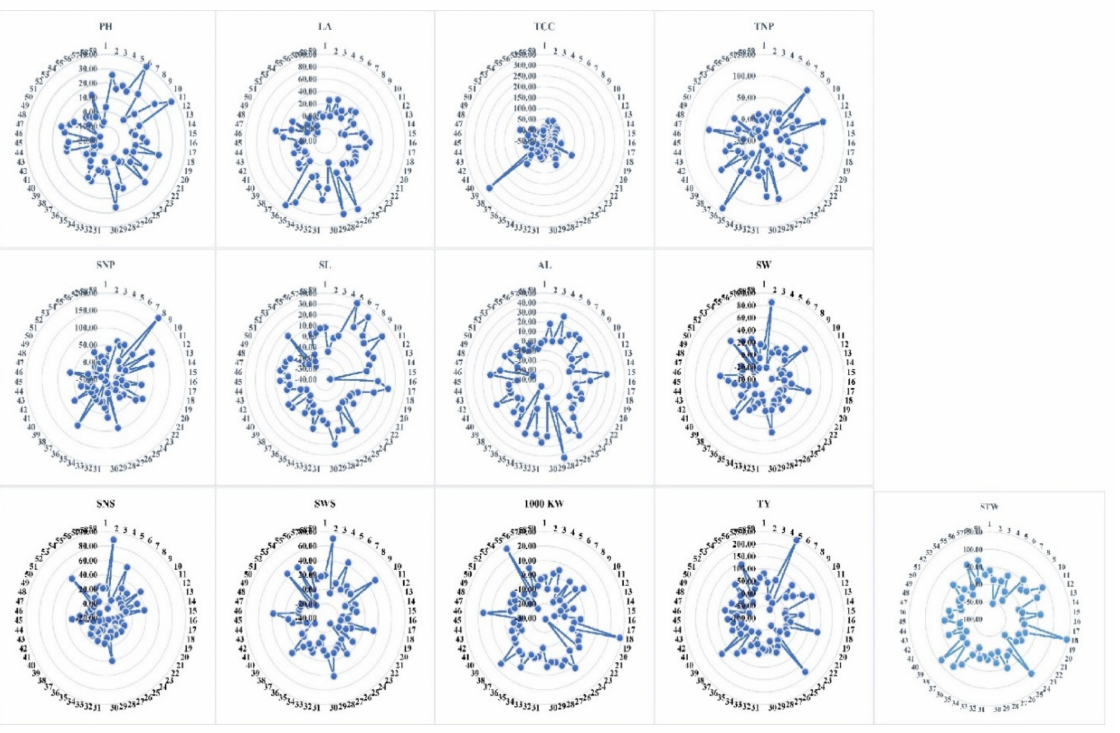
Figure 4. The radar graph depicts the responses of various accessions to MOE treatment based on growth and yield characteristics. PH: plant height, LA: leaf area, TCC: total chlorophyll content, TNP: number of the tillers per plant, SNP: number of the spikes per plant, SL: spike length, AL: awan length, SW: spike weight, SNS: number of seeds per spike, SWS: seed weight per spike, 1000-KW: 1000-kernel weight, TY: total yield per plot, STW: straw weight per plot. The numbers (1–59) represent the barley